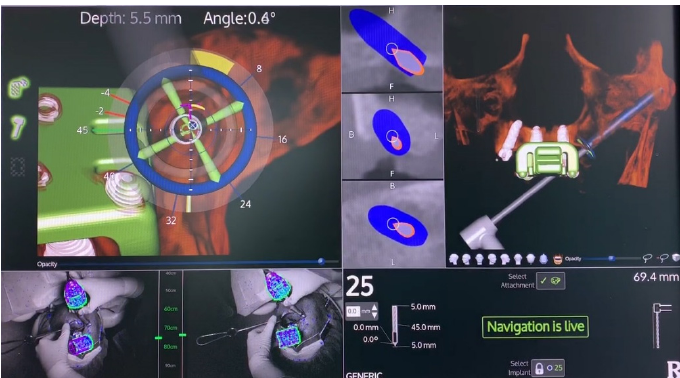
Figure 25. Spatial calibration of the drill immediately before the preparation.